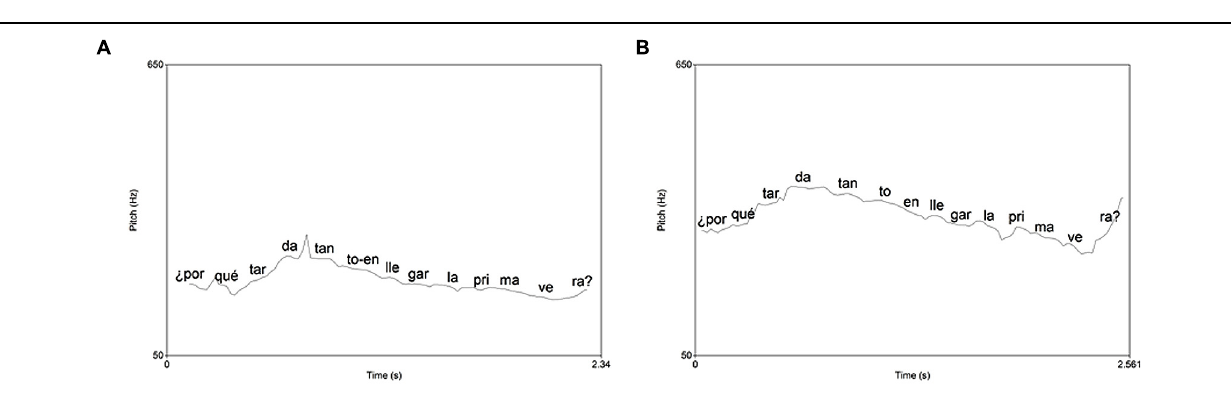
FIGURE 2 | Pitch contour of an interrogative sentence in the good comprehension group (A) and the poor comprehension group